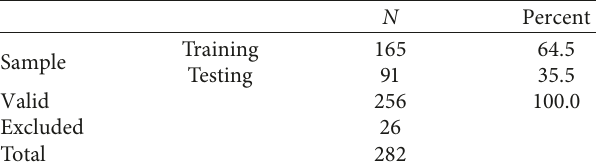
Table 12: Case-processing summary.